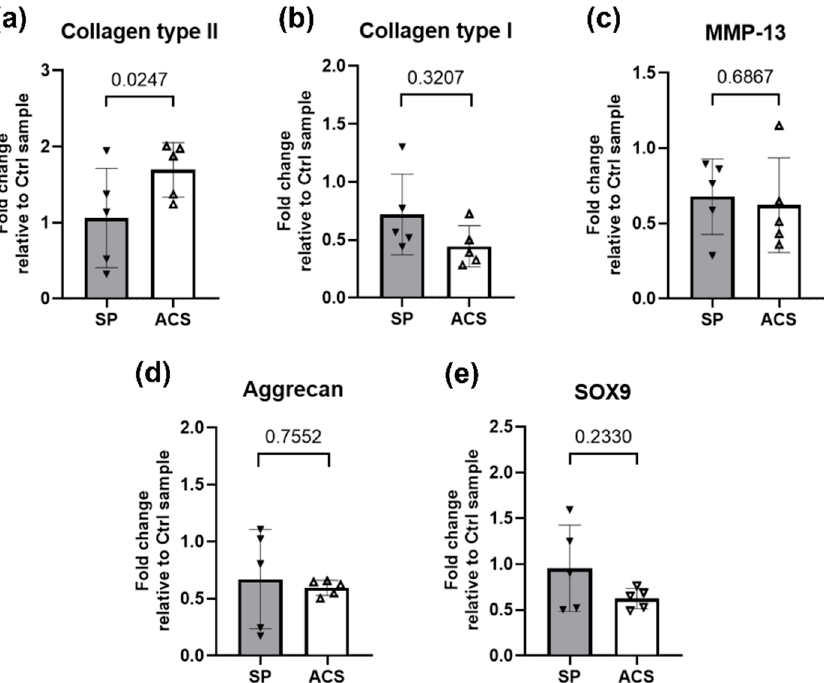
Figure 6. Effect of ACS on gene expression of cartilage matrix protein. Bar graphs show the average fold change in mRNA expressions calculated using 2 − ∆∆ CT method. Error bars depict means with SDs in all panels. Respectively, the fold change in the expression of ( a ) Collagen type II, ( b ) Collagen type I, ( c ) MMP-13, ( d ) Aggrecan, and ( e ) SOX9 are reported. Statistical differences were calculated using a two-tailed paired sample t-test. Filled and blank triangles are representatives of the mean results obtained from five individuals, two independent experiments using primary chondrocytes from two different, unrelated donors. Abbreviations, ACS; Autologous conditioned serum, SP; Sham plasma, Ctrl; Control, MMP-13; Matrix metallopeptidase 13, SOX9; SRY-Box Transcription Factor 9.